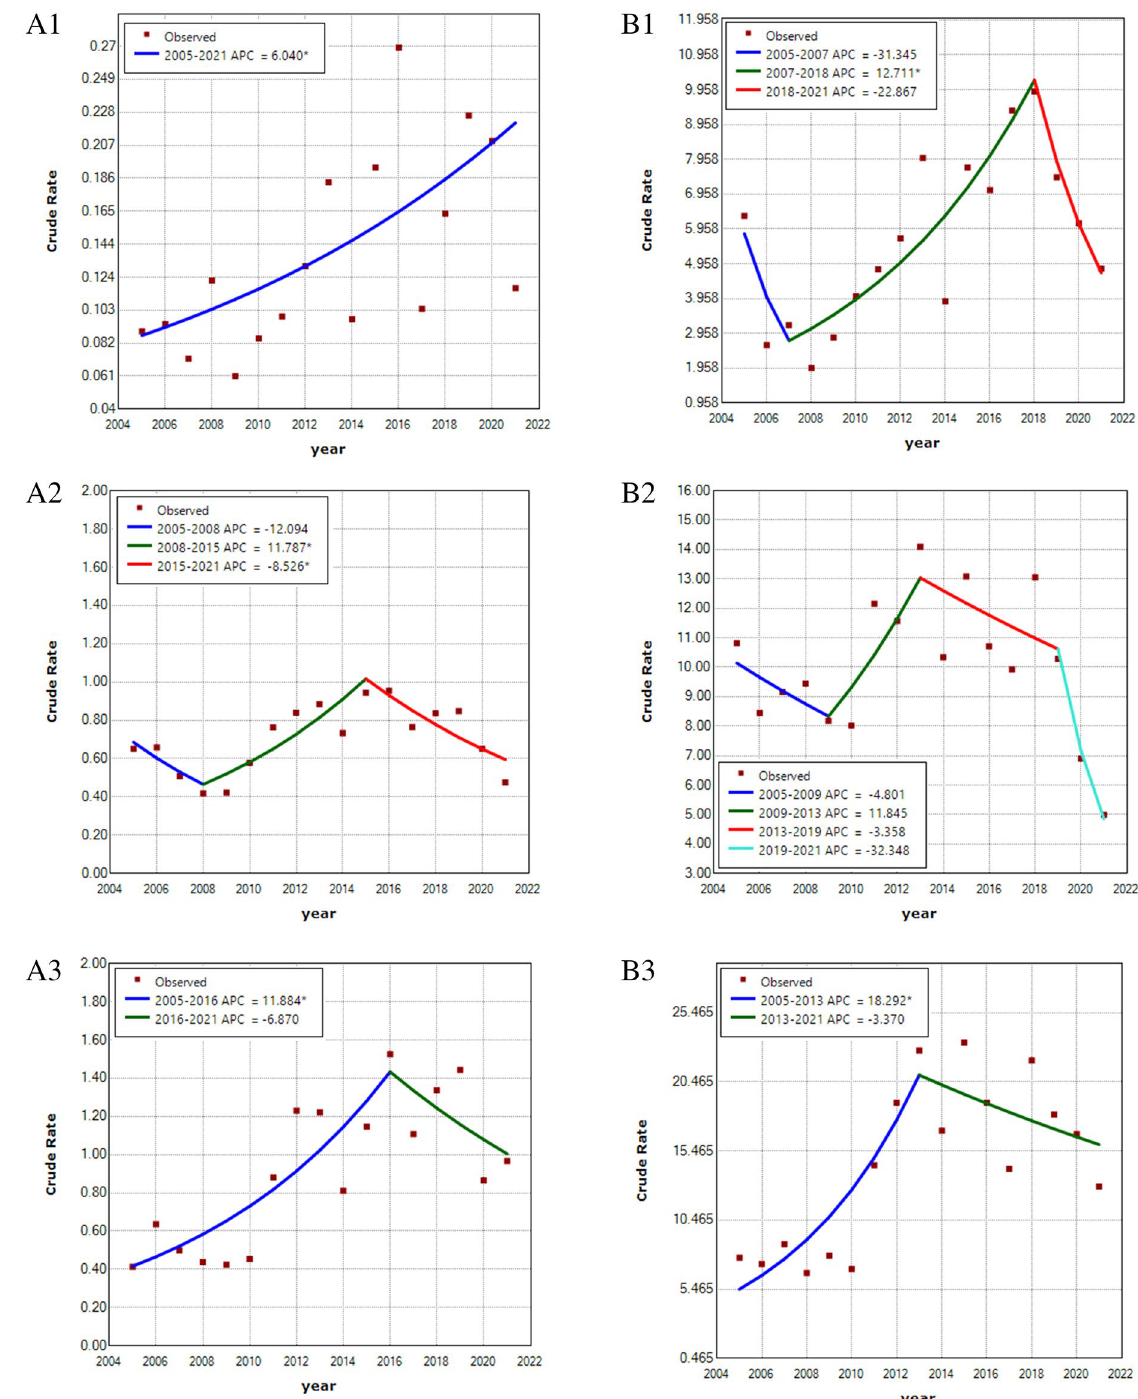
Figure 4. The trends in HFRS morbidity among the three age groups in high- and low-prevalence areas. A represents low prevalence areas and B represents high prevalence areas; 1, 2 and 3 represent 0 ~ 15 yrs, 16 ~ 60 yrs and ~ 61 yrs and older,